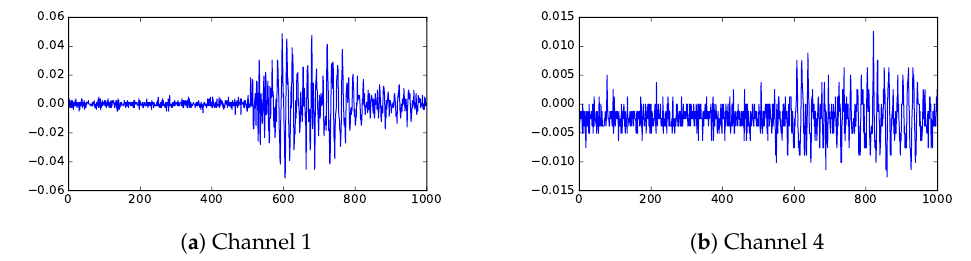
Figure 1. Sample raw data from UHF. The horizontal axis is time steps (where each step is 0.4 ns) and the vertical axis shows UHF measurements (in